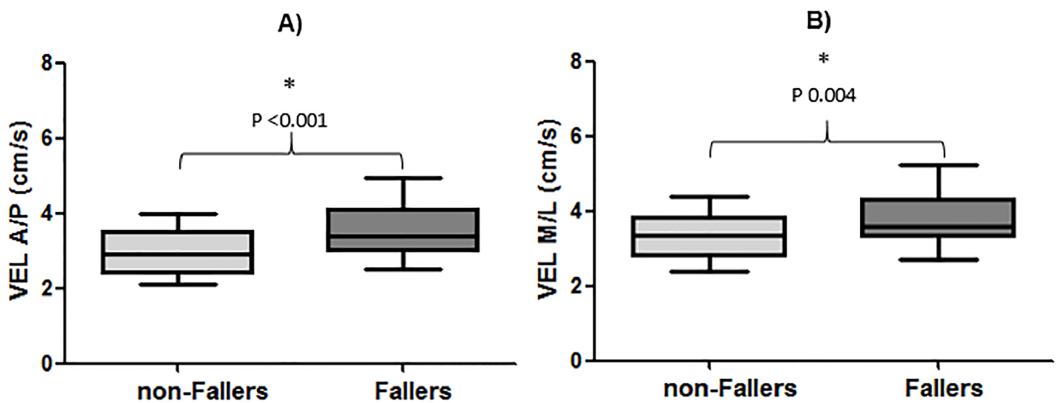
Fig 2. Comparison between groups (non-fallers and fallers) for the variables: A) Center of pressure velocity in the anteroposterior (VEL A/P) and B) mediolateral (VEL M/L) directions.